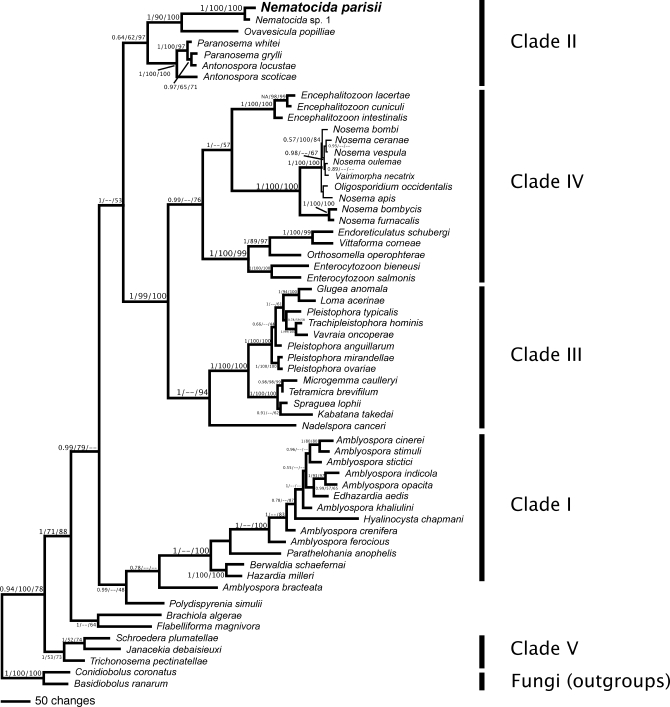
Phylogenetic Analysis of Microsporidian Sequence Isolated from Infected NematodesBayesian inference phylogeny of the small subunit ribosomal DNA from selected microsporidia and close relatives, estimated using the program MrBayes. Two fungi were used as outgroups in the analysis (see [29]). Numbers above branches are Bayesian posterior probabilities/parsimony bootstrap/maximum likelihood bootstrap values. If nodal support values were below 0.5 or below 50% for any analysis we indicated this by “—“. The five major clades of Microsporidia are indicated on the right of the figure (see [29]). Note the relationship between Nematocida and O. popilliae.